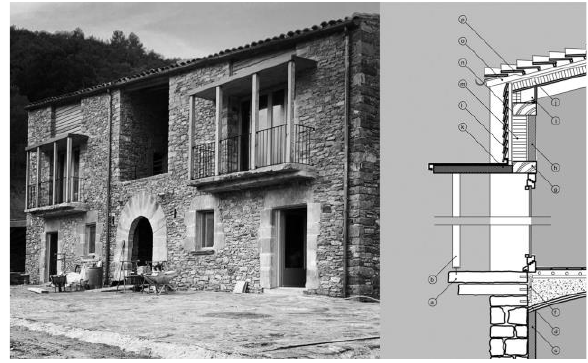
Figure 6. The complexity to set big opening on a masia by using traditional architectural references and using exclusive pre industrial materials